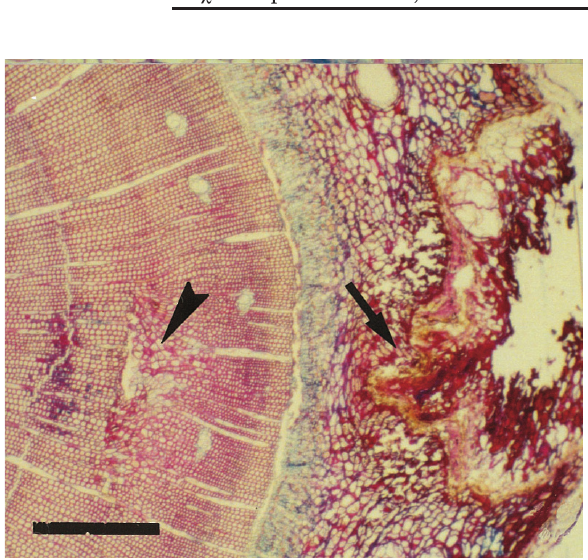
Fig. 13. Two-year-old twig with a wound caused by a feeding hole of Pissodes (arrow). Note the abnormal xylem (arrow). Bar=500 μ m (fuchsin-Astra blue).On the outer bark, the hole excavated by the weevil at the time of feeding it is still visible.